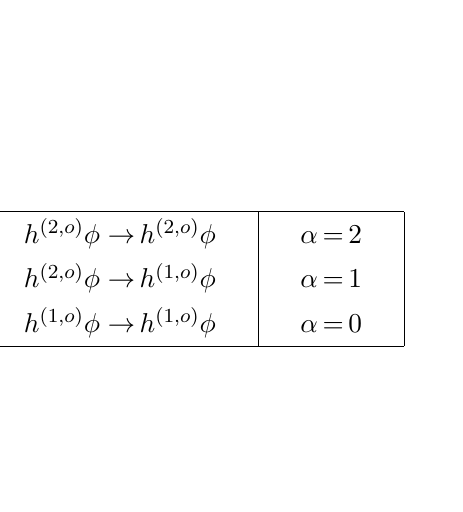
Table 1 . Energy dependence of the scattering amplitudes in the UV limit. α shows the power dependence of energy, that is, A → βE α